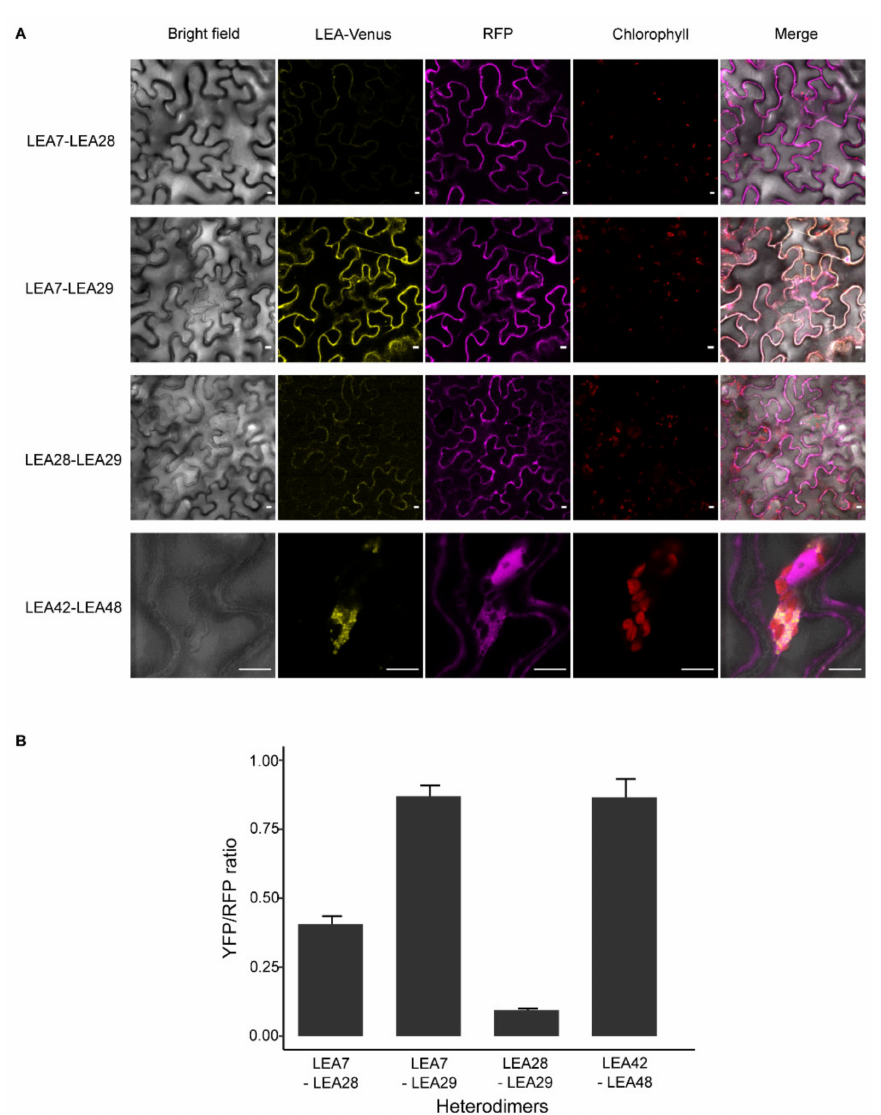
Figure 4. Heterodimeric complex formation of LEA7, LEA28, LEA29, LEA42, and LEA48 in N. benthamiana leaves 4 d after infiltration. ( A ) Confocal microscope images. RFP channel is shown as reference marker. Bars indicate 10 µ m. ( B ) Relative mean of LEA-YFP fluorescence normalized with the RFP reference marker ( n = 15-25). Error bars show standard